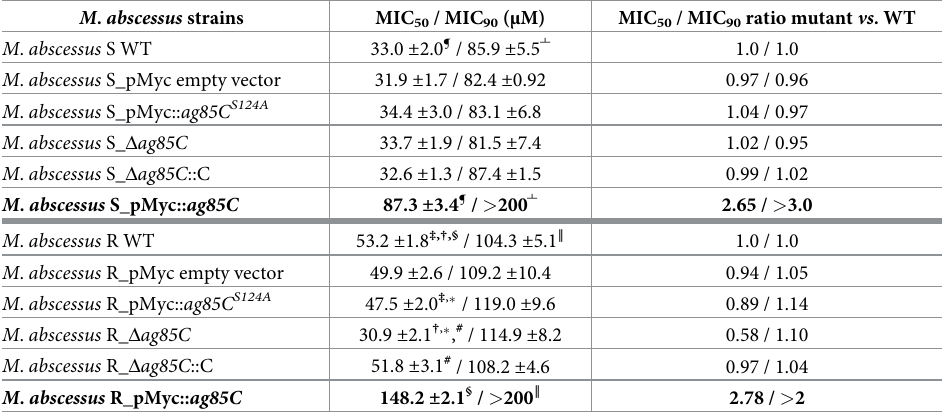
Table 3. Variation of MIC ( μ M) of iB p PPOX against M . abscessus -Ag85C-mutant strains a .